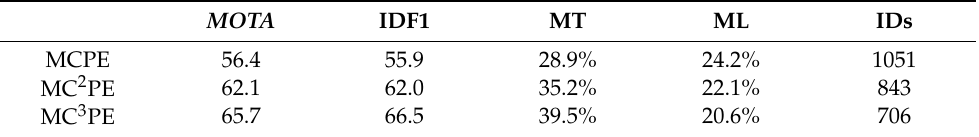
Table 5. The comparison of different size training datasets. MCPE is“MOT17 + CUHK-SYSU + PRW + ETH”; MC2PE adds Caltech; and MC3PE adds CityPersons on